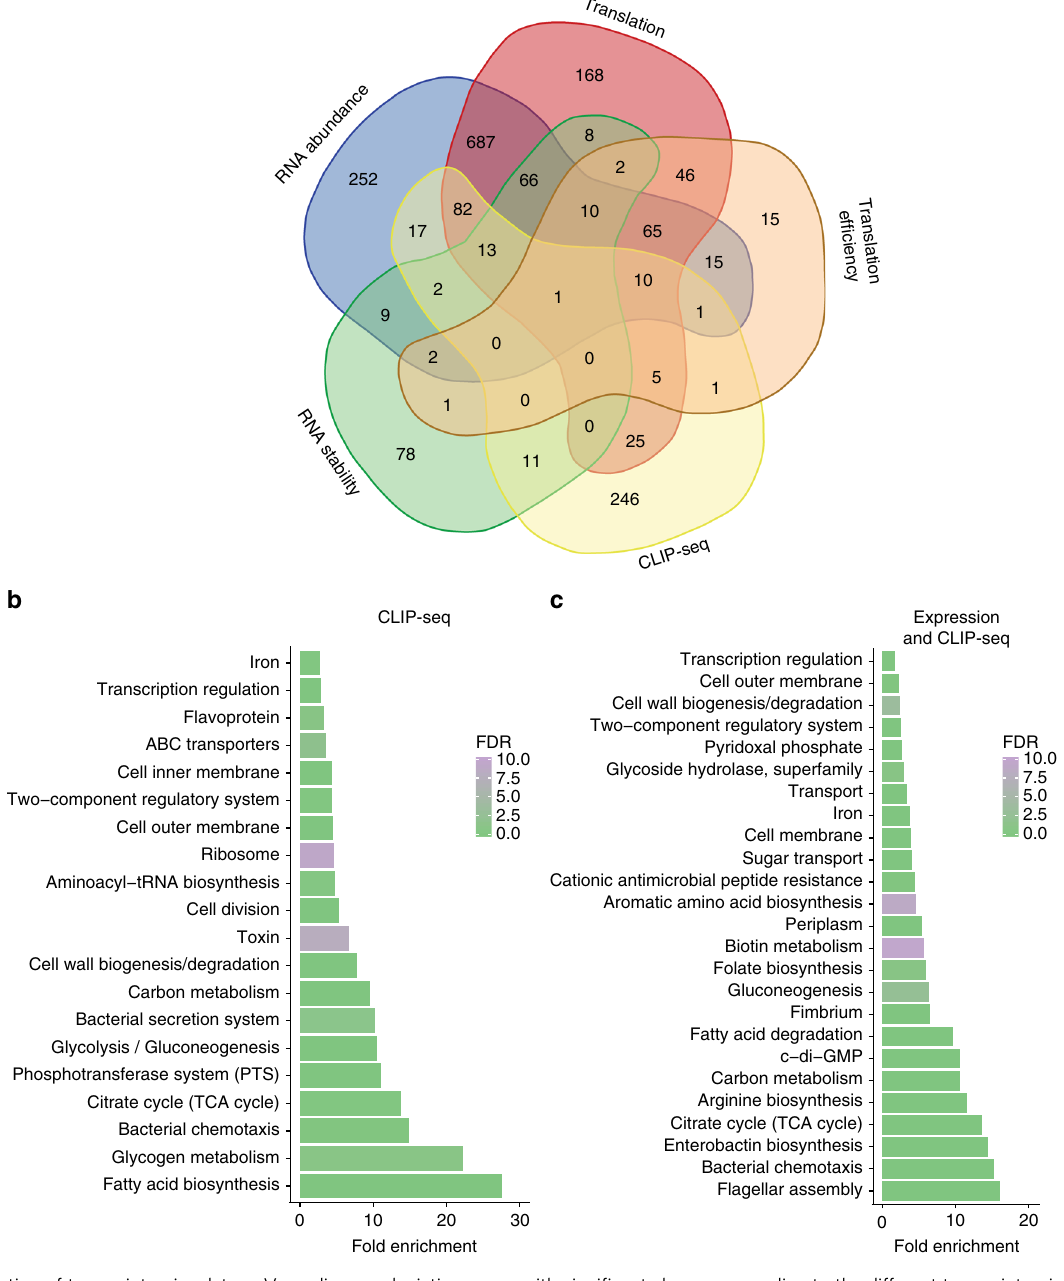
ybjX was chosen for this analysis because its downstream gene is divergently oriented and there is no evidence in our RNA-seq data for expression of an sRNA from this region (Supplementary Fig. 4a, b). About 21% of the peak annotations overlap 5 ′ -UTRs, and analysis of the relative position of peaks showed enrichment near start but not stop codons (Fig. 2c; Supplementary Fig. 3c, d). Strikingly, the majority of the peaks were found within coding sequences (CDS) of mRNAs (Fig. 2c). This was unexpected, as most of the characterized CsrA targets have binding sites in the